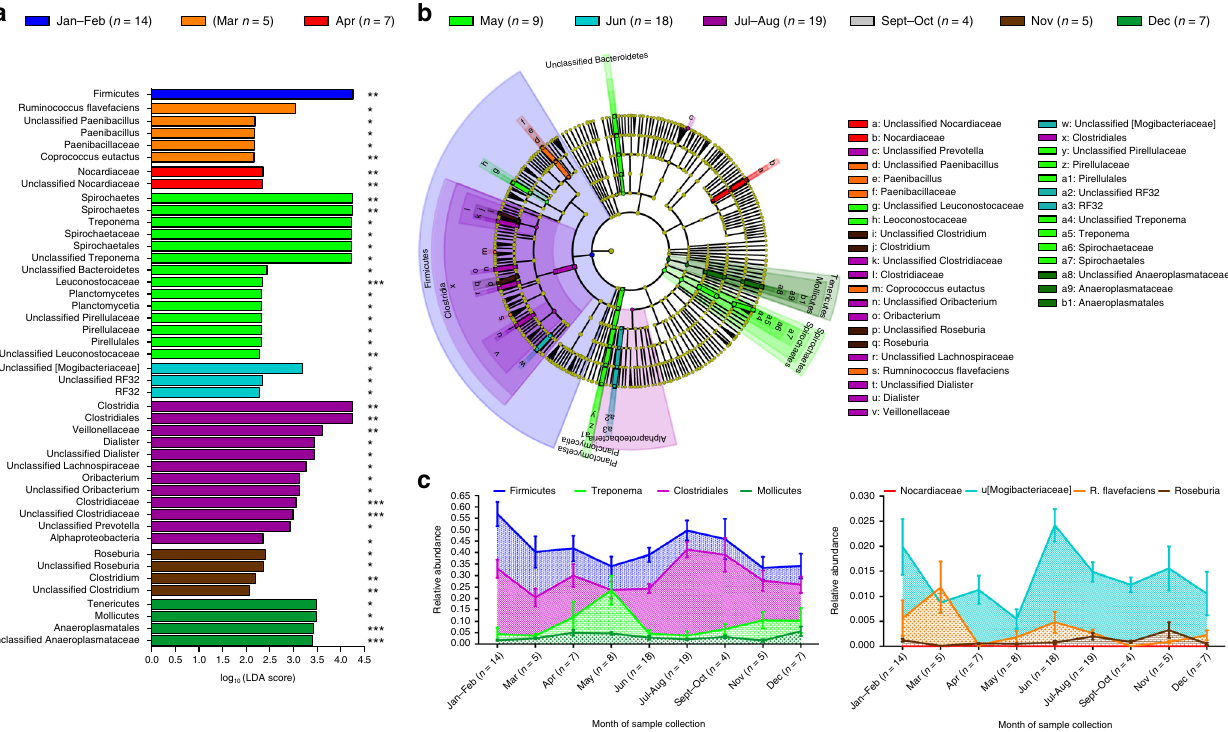
Fig. 3 The fecal microbiota composition of WLGs varies by month of sample collection. a Bar chart showing the log-transformed LDA scores and b cladogram showing the phylogenetic relationships of bacterial taxa found to be signi fi cantly associated with month of sample collection by LEfSe. Asterisks in a indicate that Box-Cox-transformed relative abundance was signi fi cantly predicted by month of sample collection in ANCOVA analyses, adjusting for the effects of potentially confounding variables (* P < 0.05, ** P < 0.01, *** P < 0.001). c Area charts showing the mean monthly relative abundance of the top bacterial taxa associated with each month. Error bars indicate the standard error of the mean